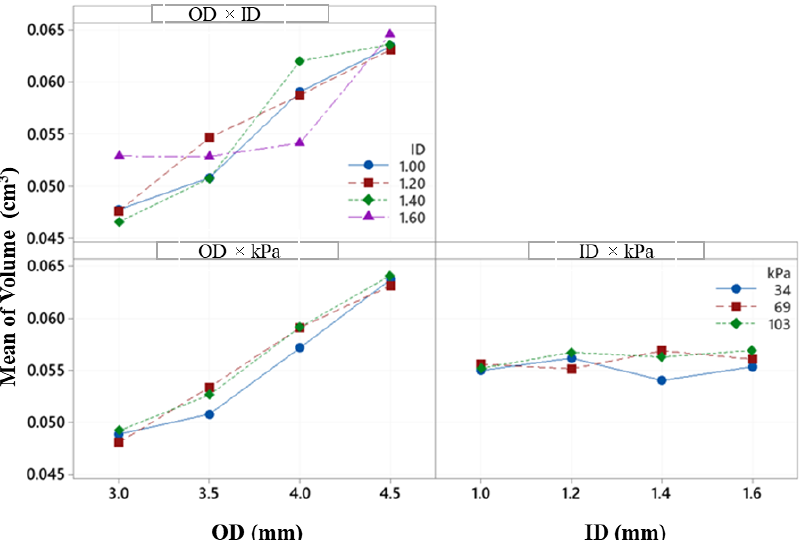
Figure 4. Two-way interactions on mean of volume/drop for pressure, outside diameter, and inner diameter.